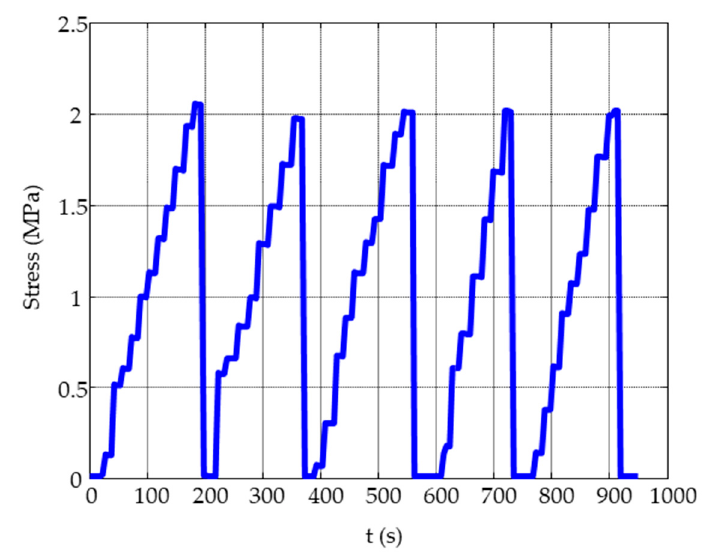
Figure 4. Compressive load and unload cycles applied on the concrete specimen.